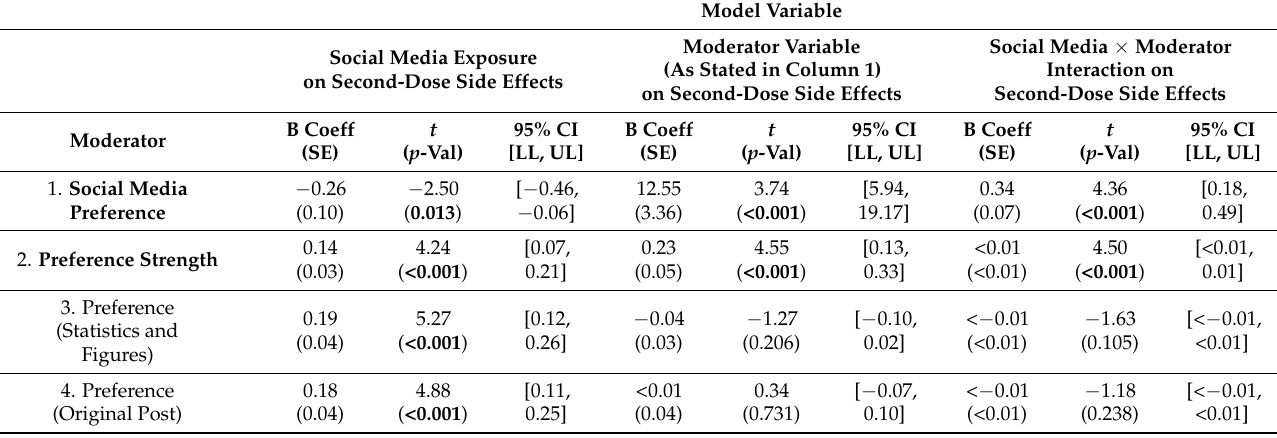
Table 3. Second dose moderation analyses—bold variables are significant moderators (note: each moderator was investigated in separate moderation